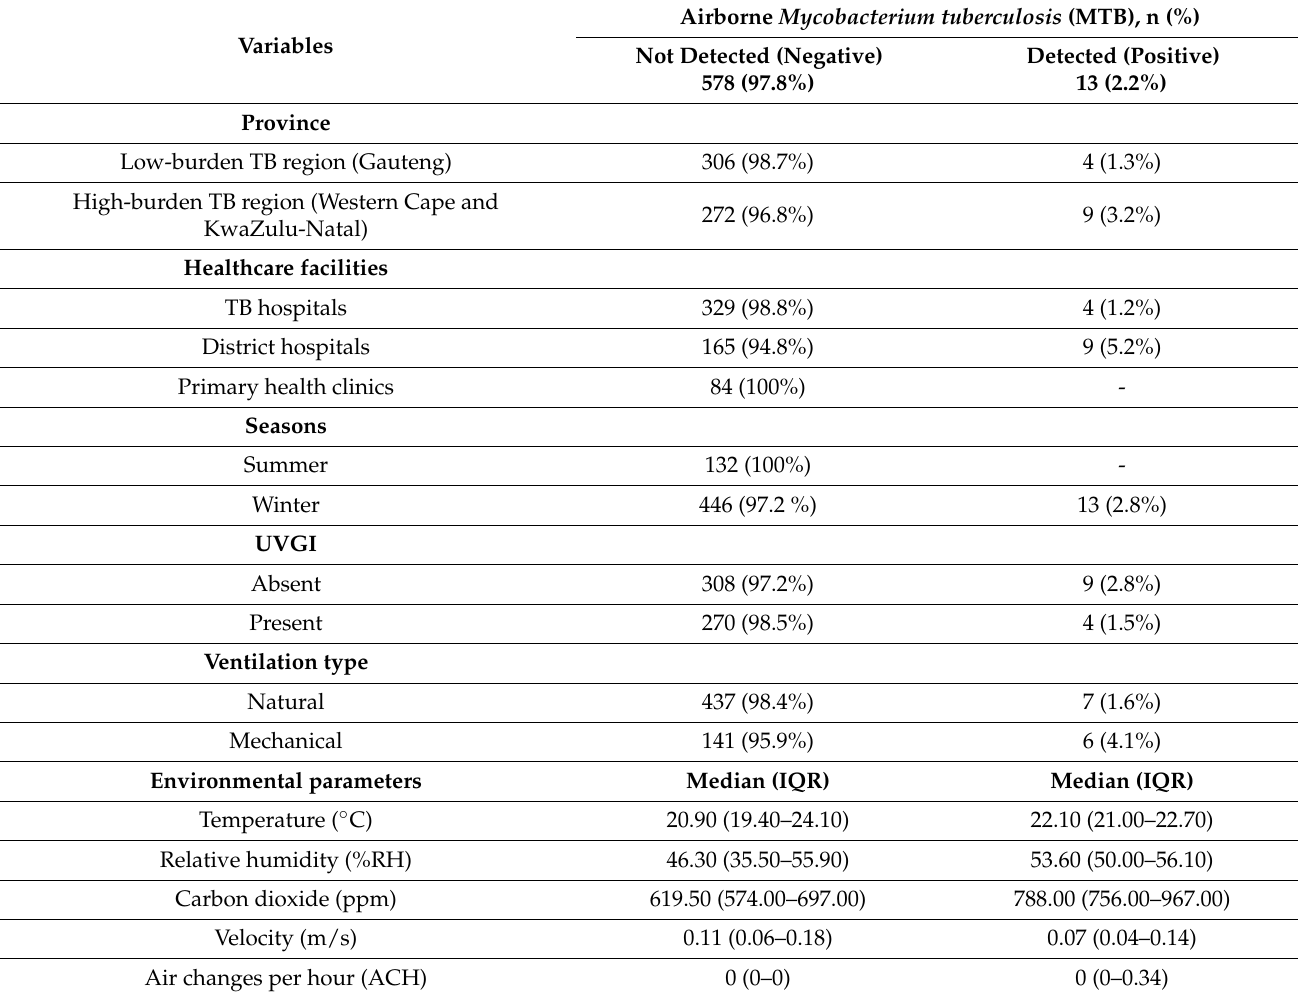
Table 2. Distribution of study characteristics by presence and absence of airborne Mycobacterium tuberculosis (MTB).